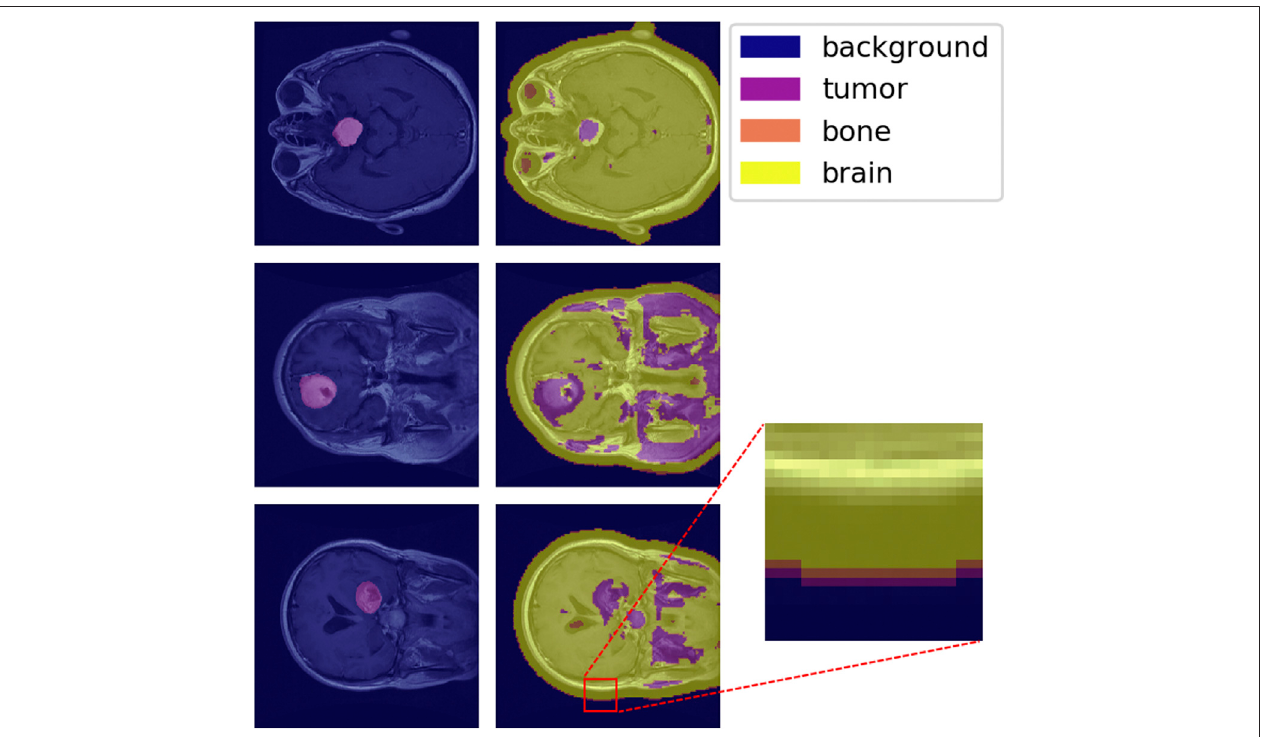
FIGURE 9 | The MAC-CNN ’ s category decisions applied in a sliding-window manner to some full brain scans. The fi rst column contains raw images with the expertlyannotatedmask ( “ tumor ” ) highlighted, while thesecondcolumncontainsraw imagesoverlaidwiththeresults fromtheMAC-CNN. TheMAC-CNN iseffectiveat detecting tumor regions, but often picks up extraneous noise. The network also appears to exhibit knowledge transfer from the knee X-rays, as it recognized bone textures around the perimeter of the skull that it learned from the knee